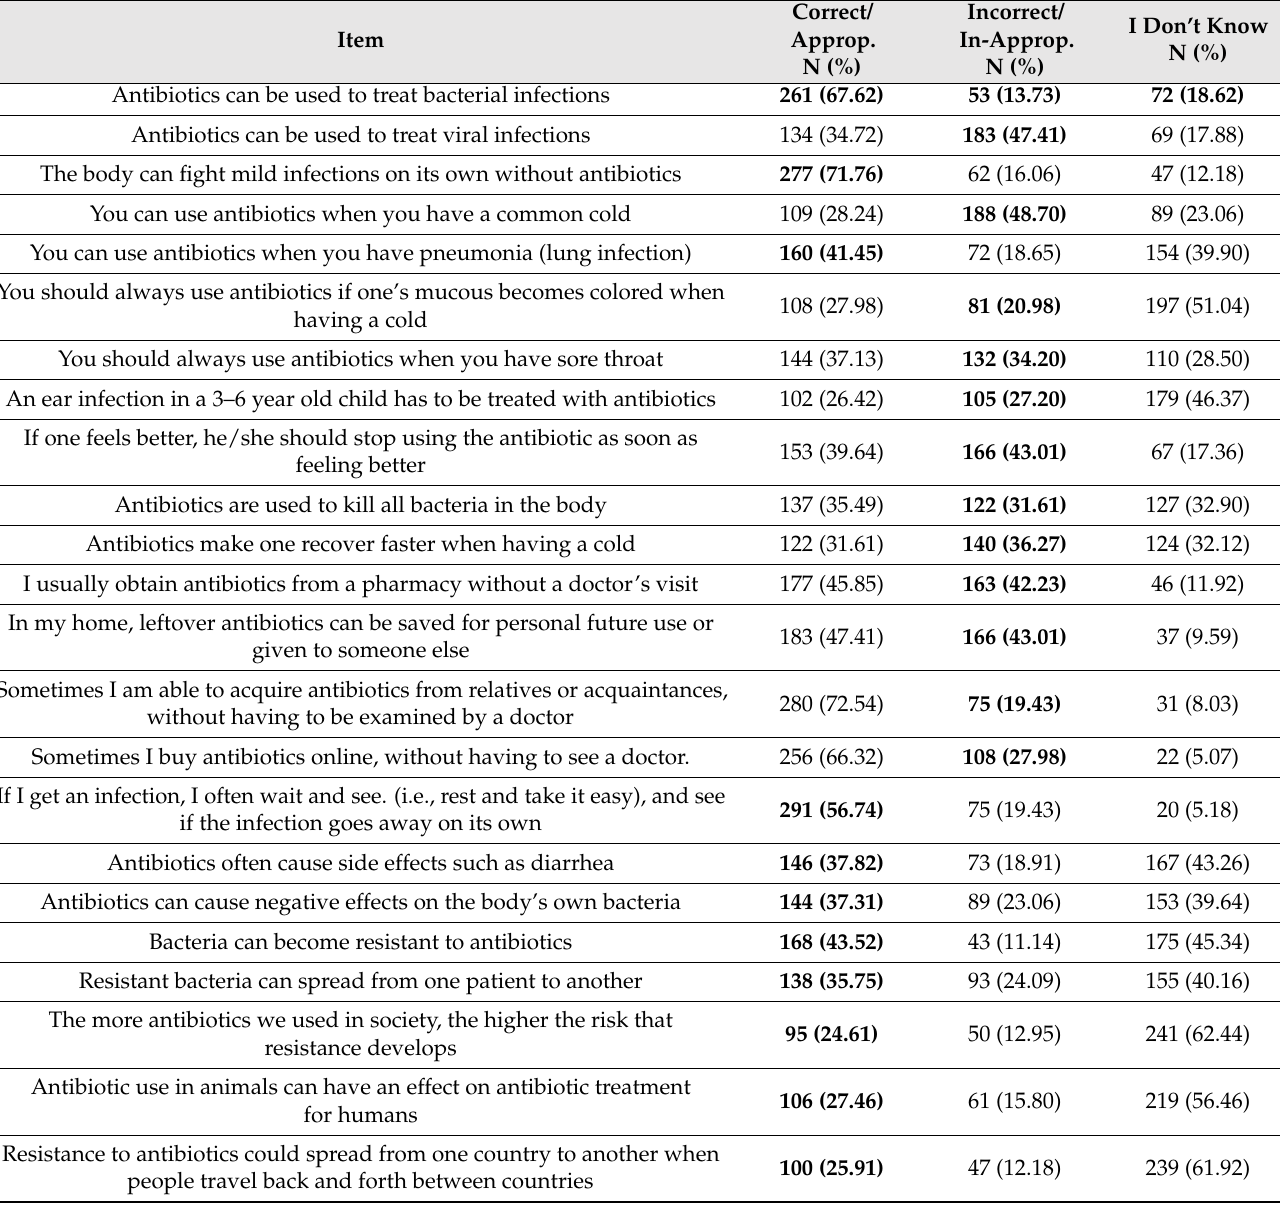
Table 2. Participant responses to questionnaire items